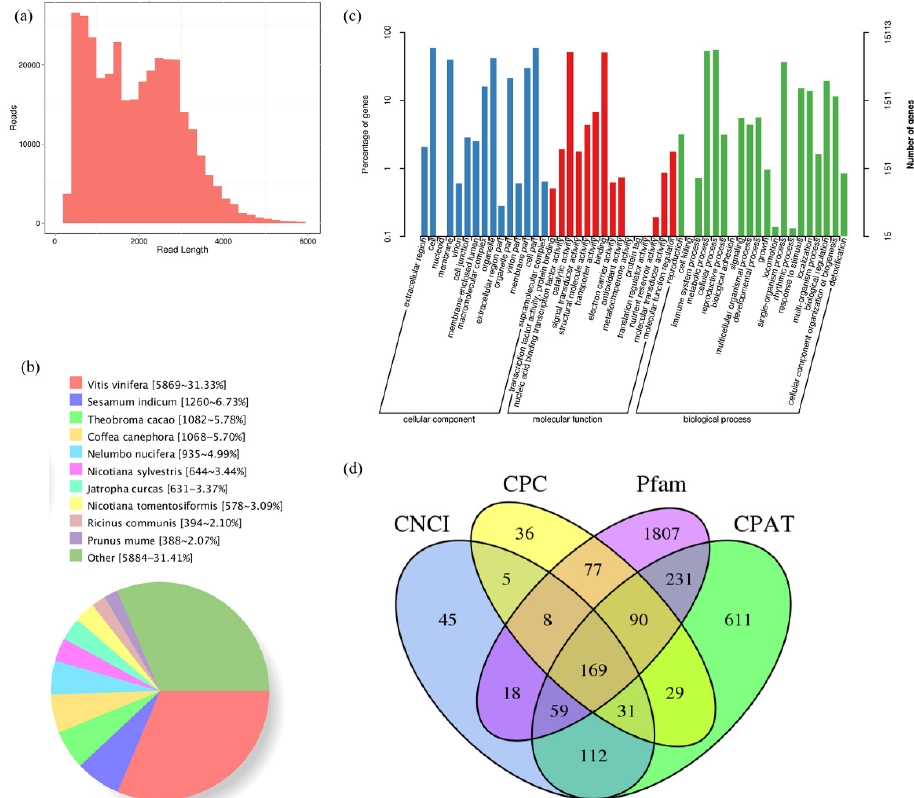
Figure 3. Overview of characteristics of A. latifolia fruit FL transcriptome. ( a ) Consensus isoform read-length distribution of 1–6 K size bin. ( b ) Homologous species distribution of A. latifolia transcripts annotated in the non-redundant database. ( c ) The alignment results against the gene ontology (GO) database. ( d ) Candidate lncRNAs predicted by CNCI, CPC, Pfam, and CPAT database.